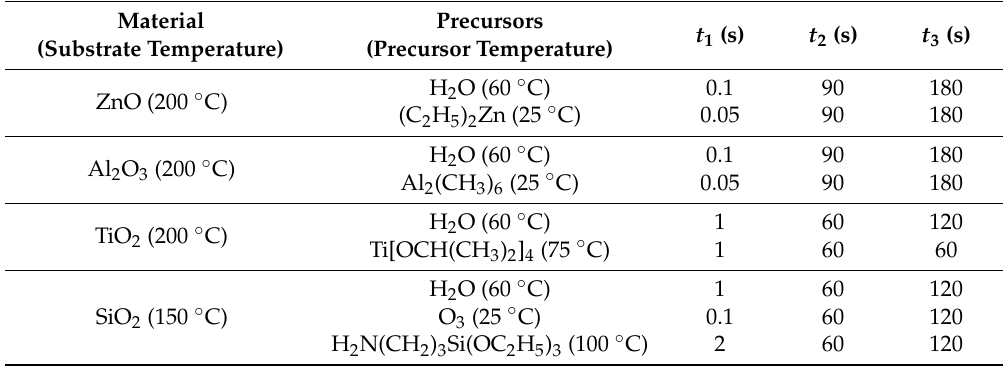
Table 1. Times and temperatures employed in the ALD processes for the different coating materials, where t 1 is the precursor pulse time; t 2 is the exposition time; and t 3 is the purge lapse. For each material, the times used in the exposure to each precursor are shown by columns, whereas the precursor and substrate temperatures are indicated by